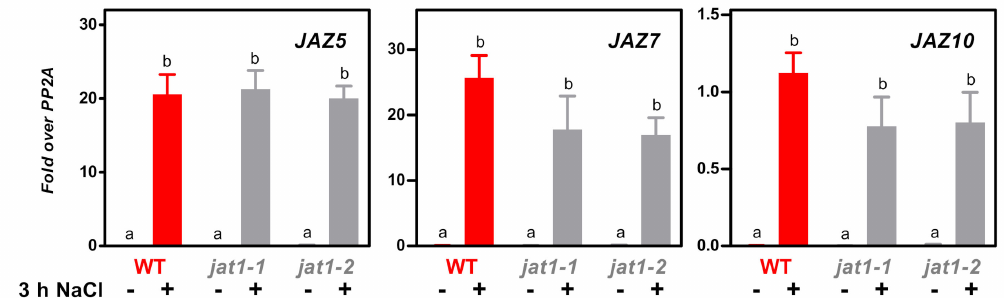
Figure 5. Quantitative RT-PCR analysis of JAZ5 , JAZ7 and JAZ10 transcripts in root material from wild-type plants and two di ff erent jat1 T-DNA insertion mutants after three hours of either control or NaCl treatment. Relative transcript levels were determined using PP2A as a reference gene. The mean values ( ± SEM) obtained from roots from four to five individually harvested plants are shown. Statistical analysis was done using a two-way ANOVA followed by Bonferroni’s post-test: lowercase letters indicate significant di ff erences ( p < 0.05) between control and NaCl treatment performed with the same genotype; there are no significant di ff erences between genotypes subjected to the same treatment. Reduced JAT1 transcript levels in the jat1 mutants are depicted in Supplementary Figure